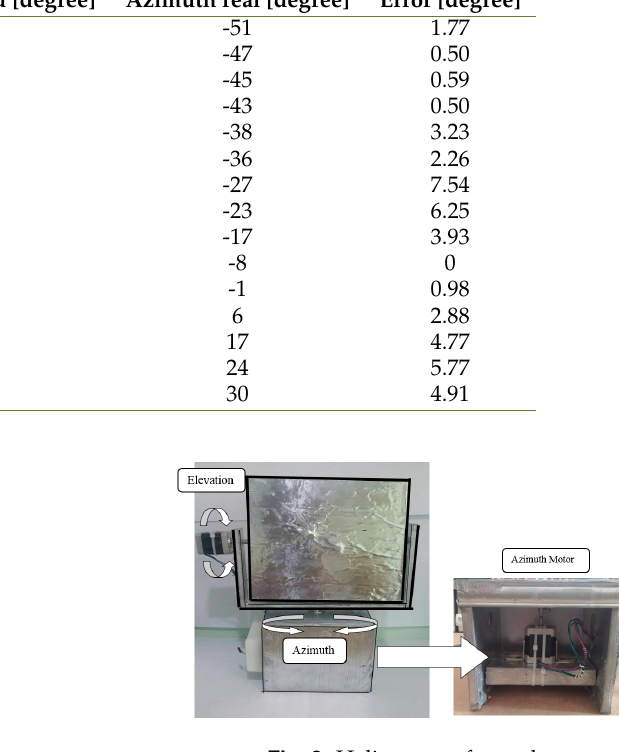
Fig. 8. Heliostat performed